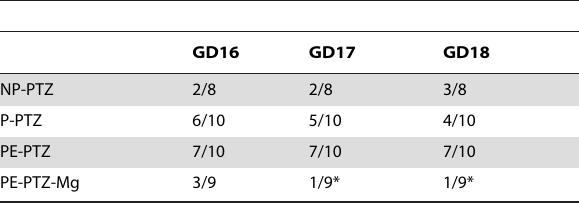
Table 3. The total stage 5 seizure ratio within 30 min was compared in each group on each day of PTZ treatment.